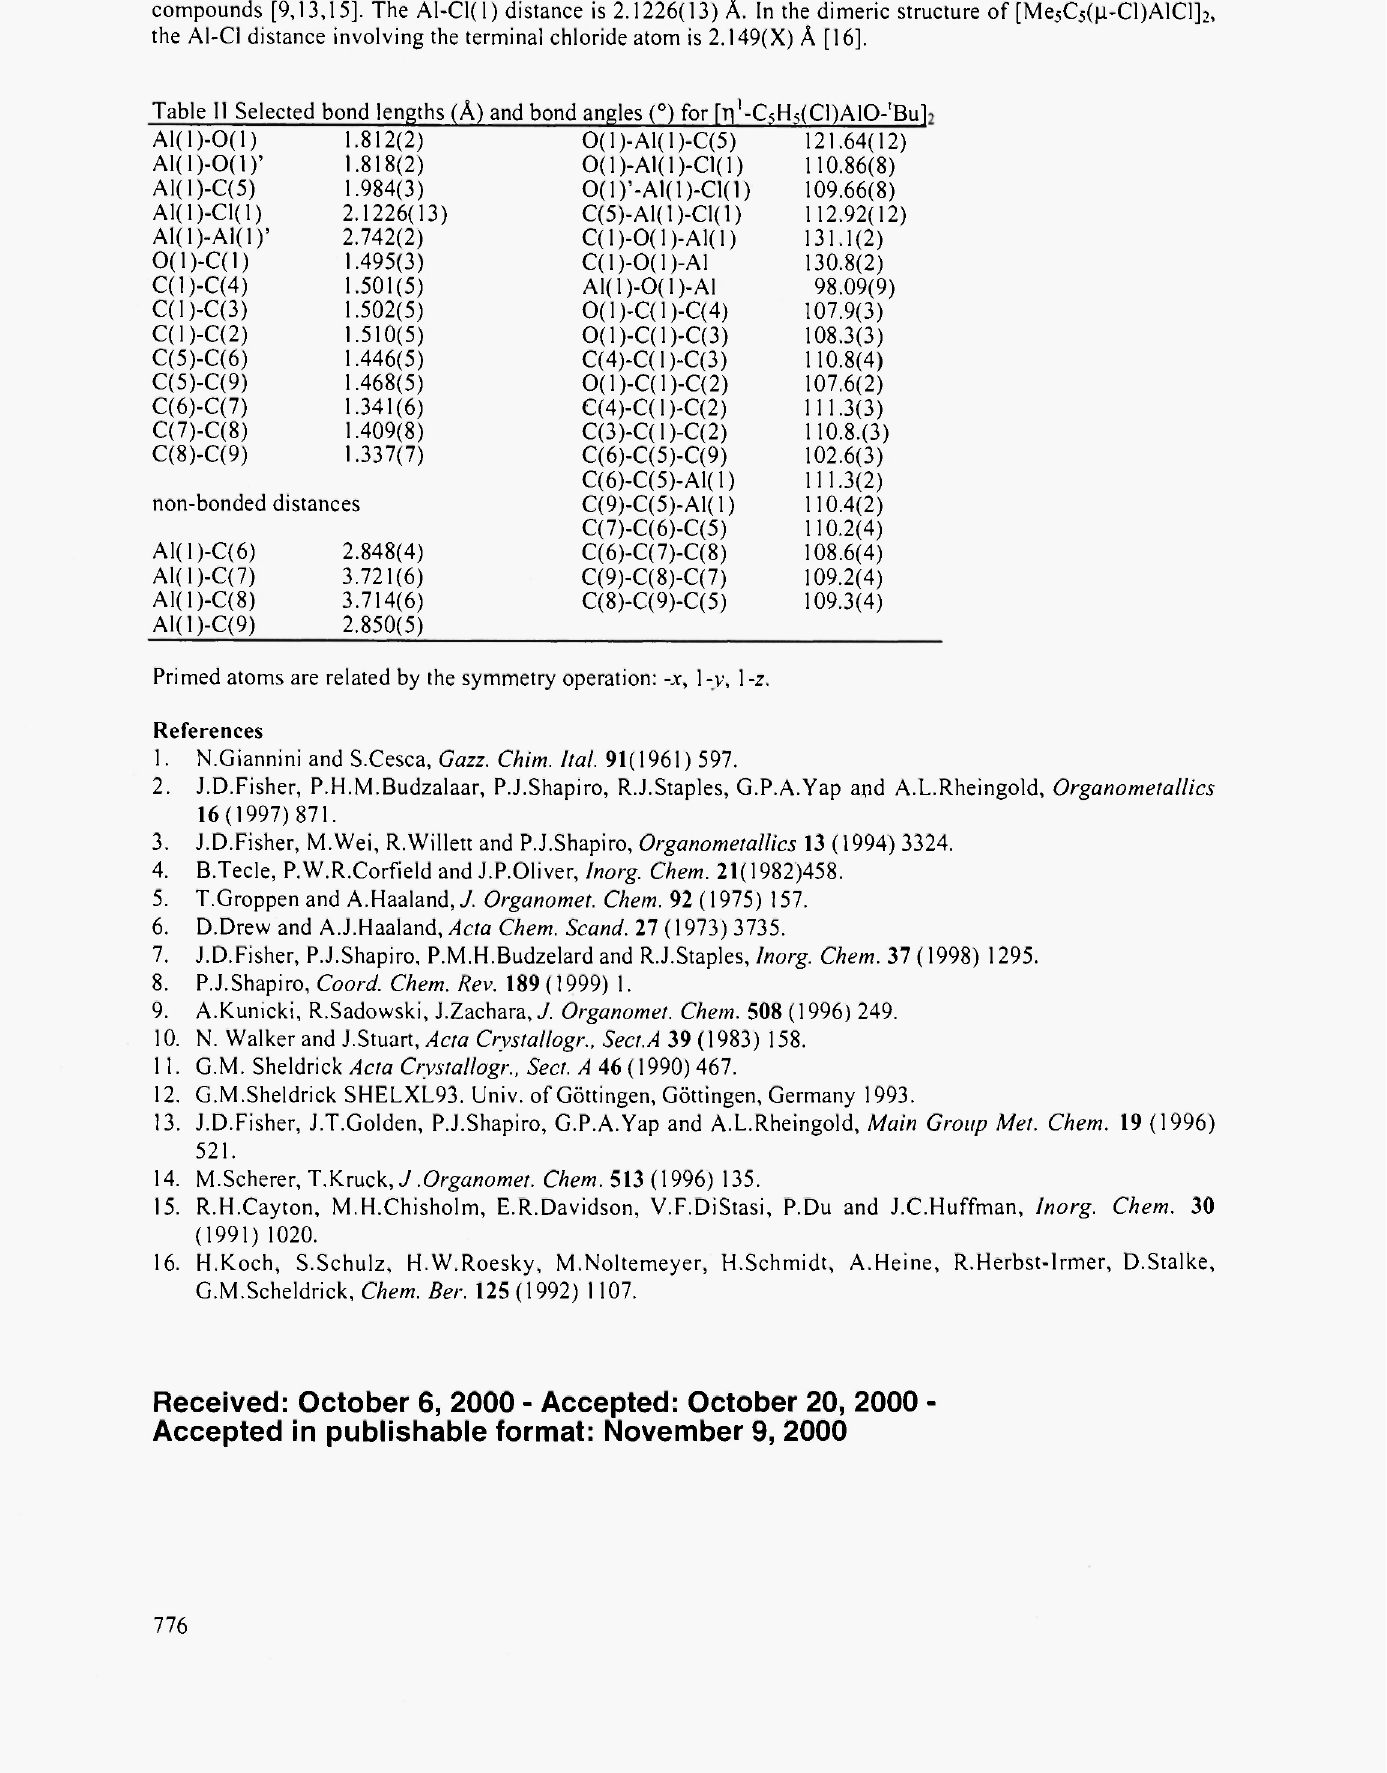
Table 11 Selected bond lengths (A) and bond angles (°) for [η 1 - CjHjfCOAlO-'Bul